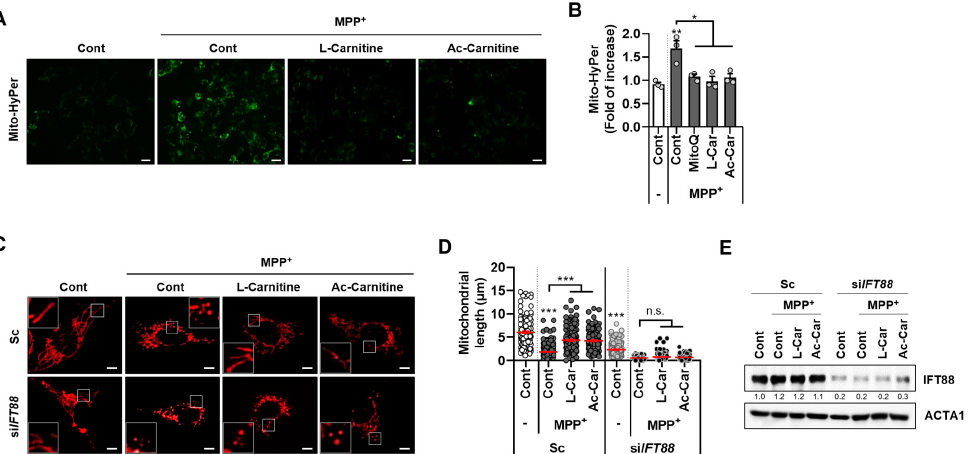
Figure 2. Carnitine inhibits excessive generation of mitochondrial ROS and mitochondrial frag- mentation by MPP + in SH-SY5Y cells. ( A , B ), SH-SY5Y cells stably expressing mito-HyPer protein (SY5Y/mito-HyPer cells) were treated with MPP + (2.5 mM) in the presence or absence of L-carnitine (L-Car, 100 µM) or Ac-L-carnitine (Ac-Car, 100 µM) for 24 h. Next, the fluorescence intensity of mito- HyPer was imaged ( A ) and the fluorescence was measured (B). Scale bar: 20 µm. Data are presented as the mean ± SEM ( n = 3, * p < 0.05, ** p < 0.01). ( C – E ), SH-SY5Y cells stably expressing mito-RFP protein (SY5Y/mito-RFP cells) were transiently transfected with either scrambled siRNA (Sc) or tar- geted siRNA for IFT88 (si IFT88 ). These cells were then treated with MPP + (2.5 mM) in the presence or absence of L-Carnitine (100 µM) or Ac-L-Carnitine (100 µM) for 24 h. Then, Mito-RFP in the cells was imaged using fluorescence microscopy ( C ), and the mitochondrial length was assessed ( D ). The SH-SY5Y cells were harvested and analyzed by western blotting with indicated antibodies ( E ). Data are presented as the mean ± SEM ( n = 3, *** p < 0.001, n.s. = not significant). Scale bar: 5 µm.